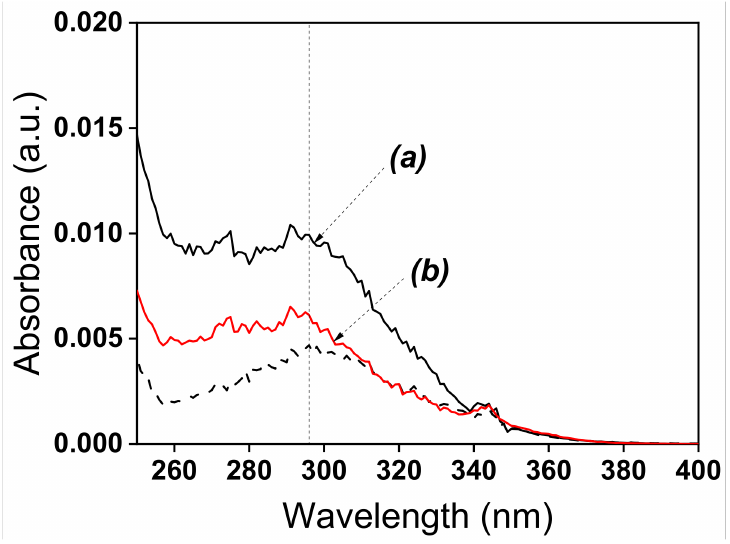
Figure 5. UV-Vis diffuse reflectance spectra of: (a ) Talc, and ( b ) TalcNH 2 . The dot line corresponds to the reflectance standard BaSO 4